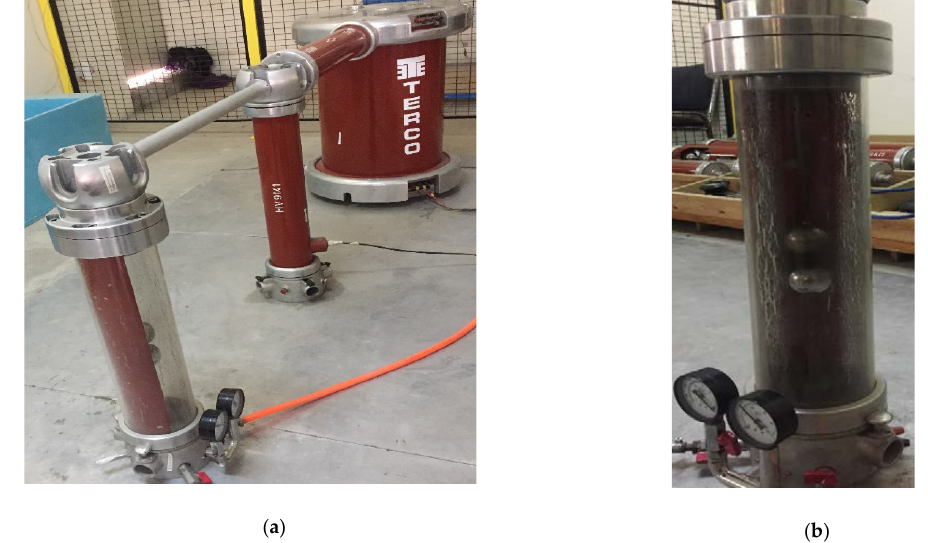
Figure 2. Test equipment used: ( a ) experimental setup; ( b ) testing vessel (HV-9134);